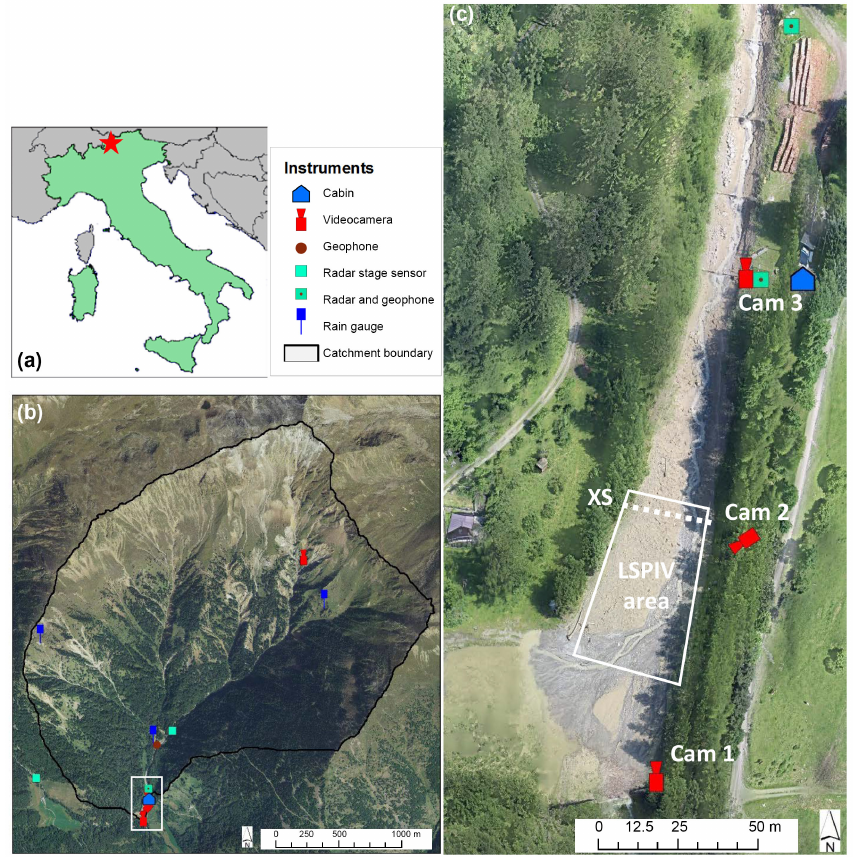
Figure 1. Gadria catchment is situated in the Venosta (Vinschgau) Valley, South Tyrol, Italian Alps ( a , red dot). The catchment is equipped with rain gauges, radar stage sensors, video cameras, and geophones (b) . At the end of the catchment (c) is a sediment retention basin where most of the instrumentation is kept; XS: cross sections used in LSPIV